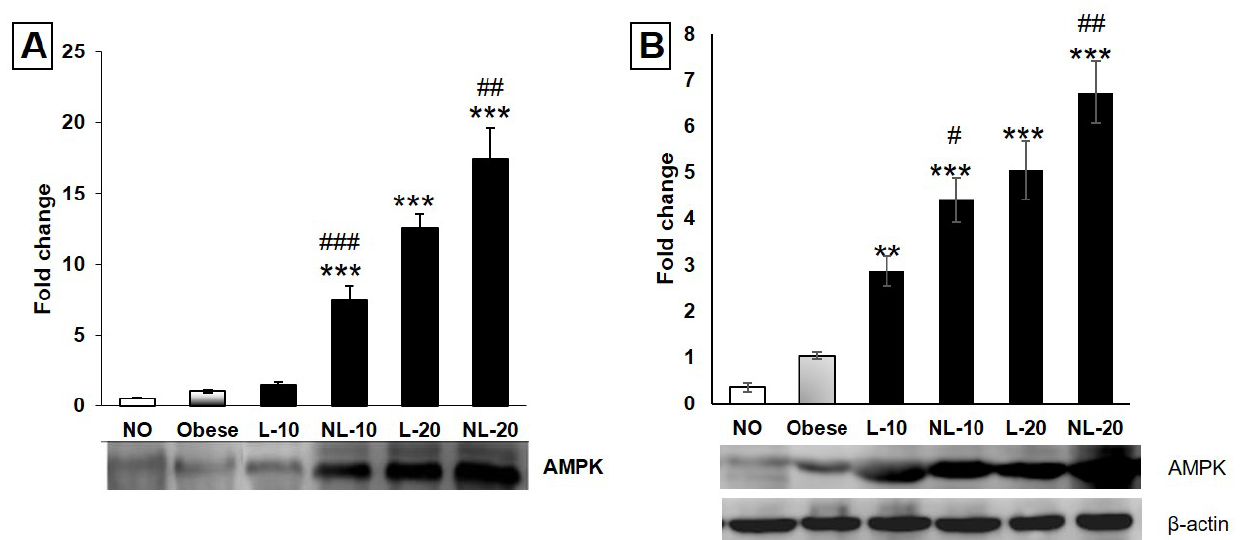
FIGURE 4- Effect of lupine oil on AMPK expression: (a) Expression of AMPK in epididymal fat determined by Western blot analysis. (b) Expression of AMPK in liver homogenate determined by Western blot analysis. NO: non-obese group, Obese: obese untreated group, L-10 and L-20: crude lupine oil treated groups after 10 and 20 days, NL-10 and NL-20: Lupine oil nanoemulsion treated groups after 10 and 20 days. Data are represented as means ± SD, ( n = 5). * P < 0.05, ** P < 0.01 and *** P < 0.001 when compared with obese untreated values. # P < 0.05, ## P < 0.01 and ### P < 0.001 when crude oil preparation group is compared to its corresponding nanoemulsion formulation group (N-10 versus NL-10 and L-20 versus NL-20).